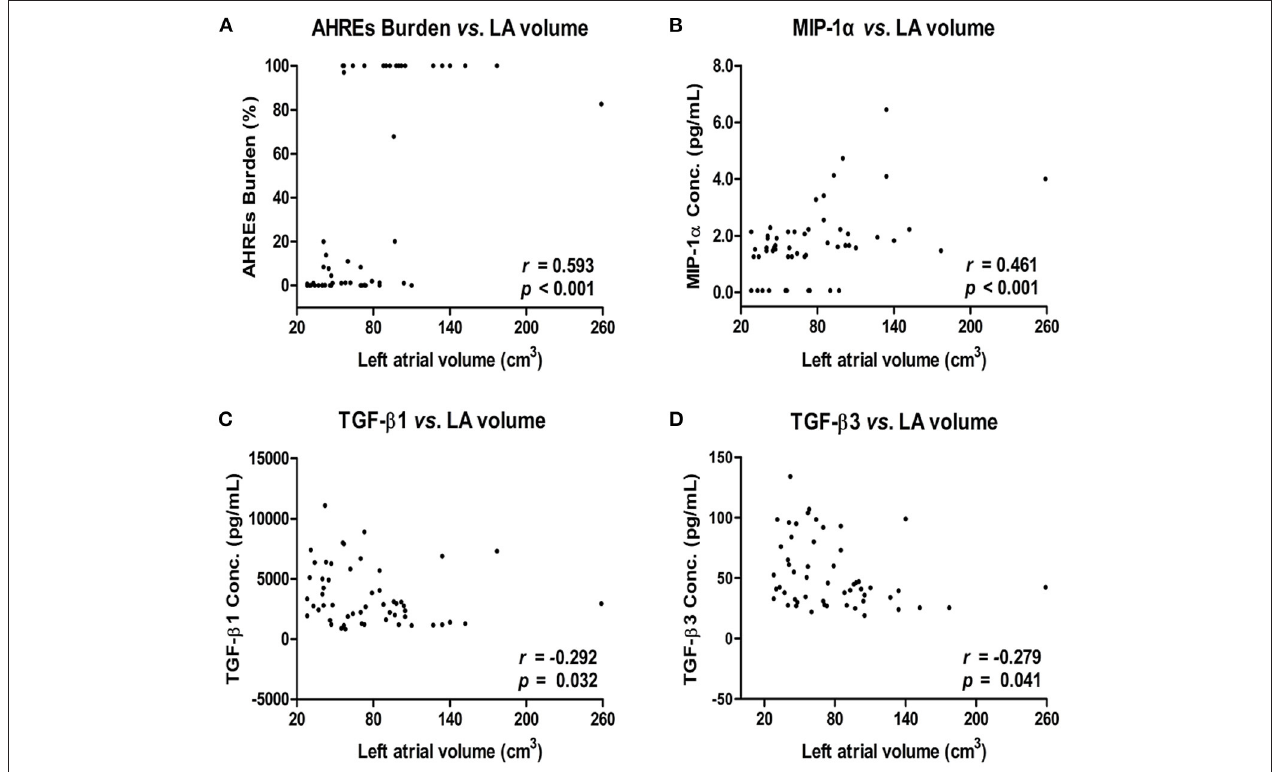
FIGURE 2 | Correlation between left atrial (LA) volume and AHREs burden (A) and LA volume and cytokine levels [MIP-1 α (B) , TGF- β 1 (C) , and TGF- β 3 (D) ] in patients with AF. The correlation was assessed by bivariate correlation analysis. The r and p -values indicate the correlation between the expression levels of cytokines and LA volume (expressed as units of cm 3 ). AHREs, atrial high-rate episodes; MIP-1 α , macrophage inflammatory protein-1 alpha; TGF- β , transforming growth factor beta.